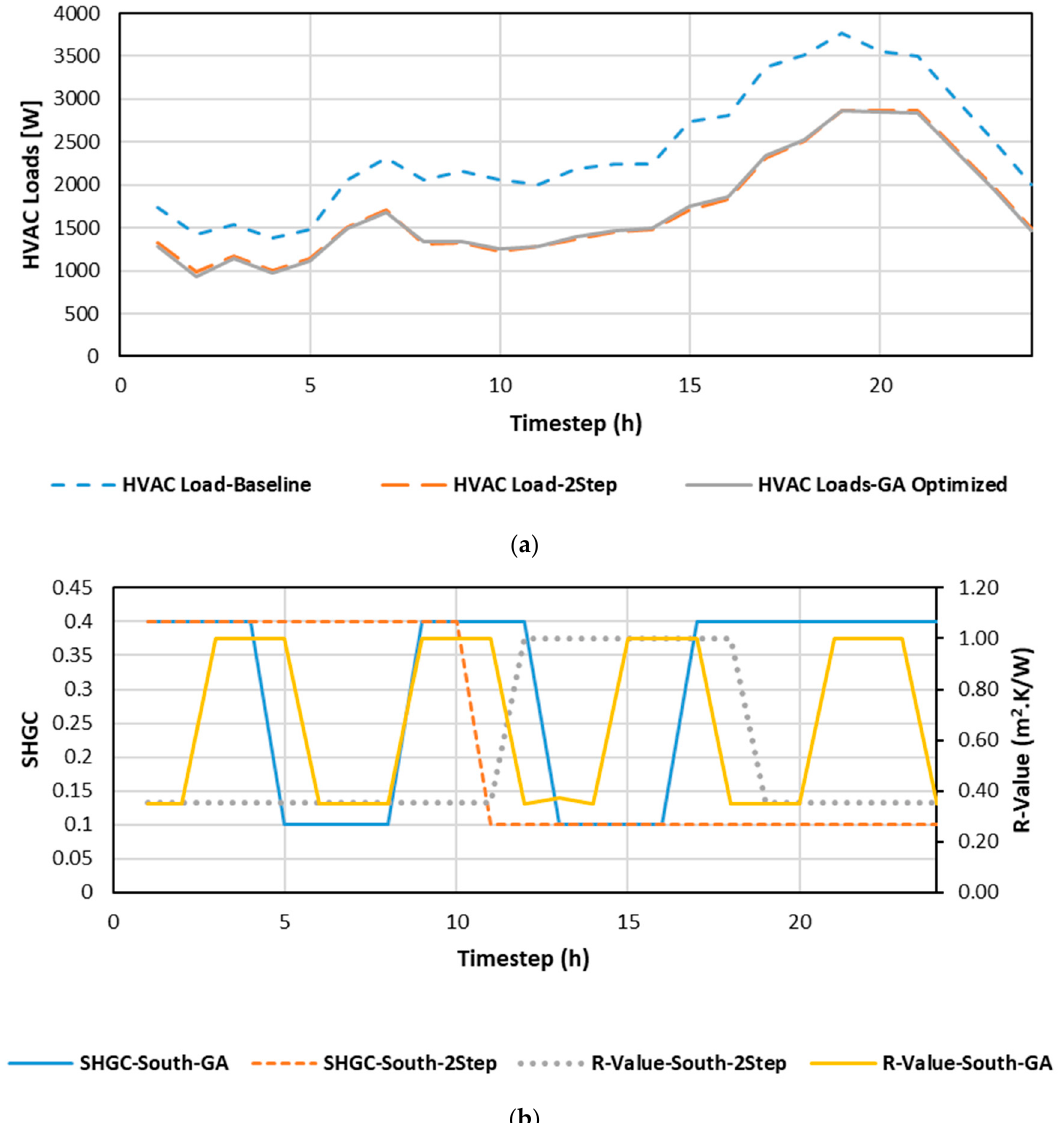
Figure 8. Hourly variations of ( a ) R-values and SHGC settings, and ( b ) thermal loads for an STIS–smart window with southern exposure during a summer day (13 July) for a dwelling located in Golden, CO, USA.